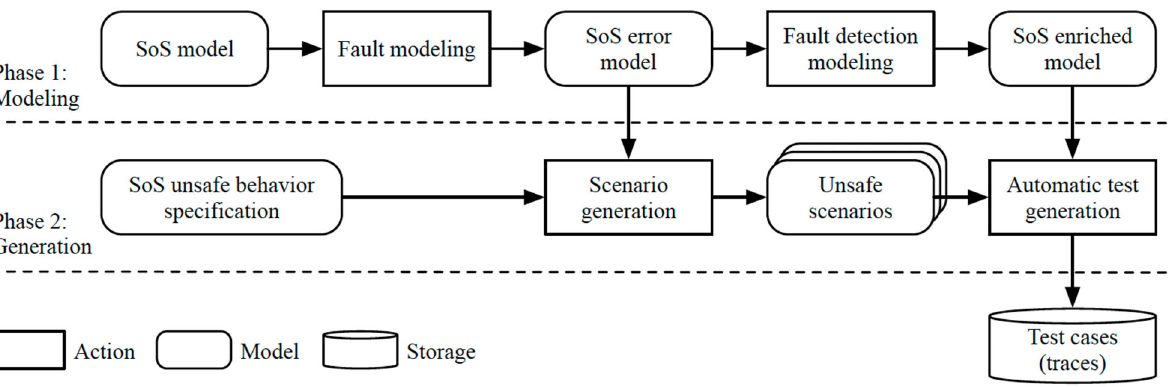
Figure 1. SoS test case generation methodology designed with two phases, modeling and generation.